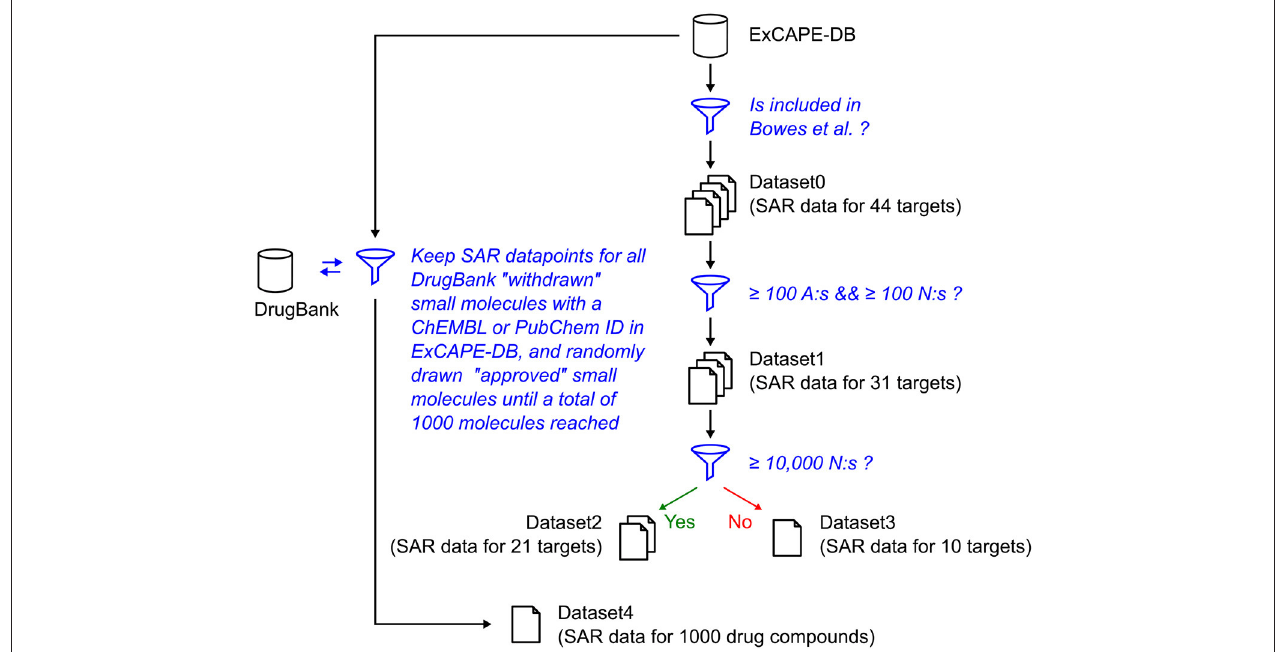
FIGURE 1 | Graphical overview over how the raw datasets used in this study were created. The blue funnel symbol and text represent filtering steps, while the barrel and document symbols represent datasets. The criteria for the filtering steps are shown with blue text. “A” represents “Actives,” and “N” represents “Non-actives.”